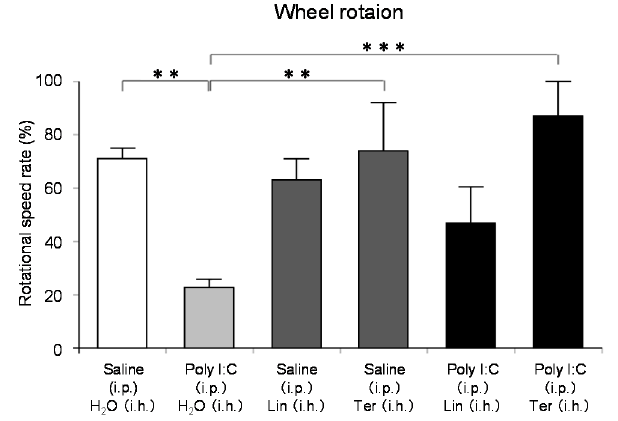
Figure 9. Effects of thyme components, linalool and (+)-terpinen-4-ol, on mouse behavior. A brain